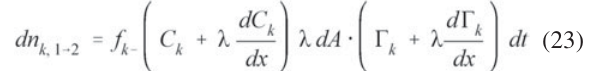
Figure 8. Schematic representation of two adjacent planes in a solid, emphasizing the diference in the concentration and jump frequency of a particular species upon each of the